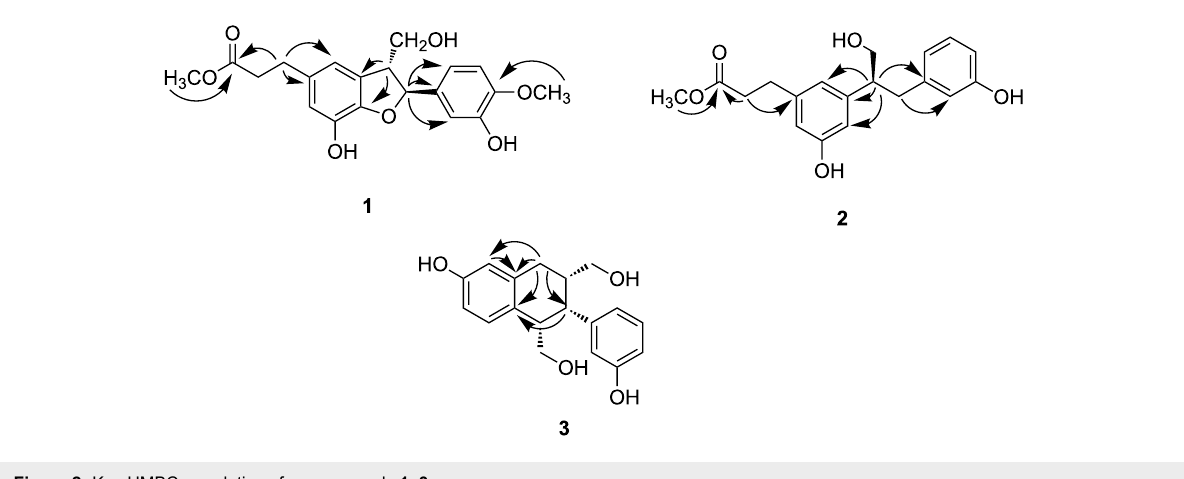
Figure 2: Key HMBC correlations for compounds 1 – 3 .